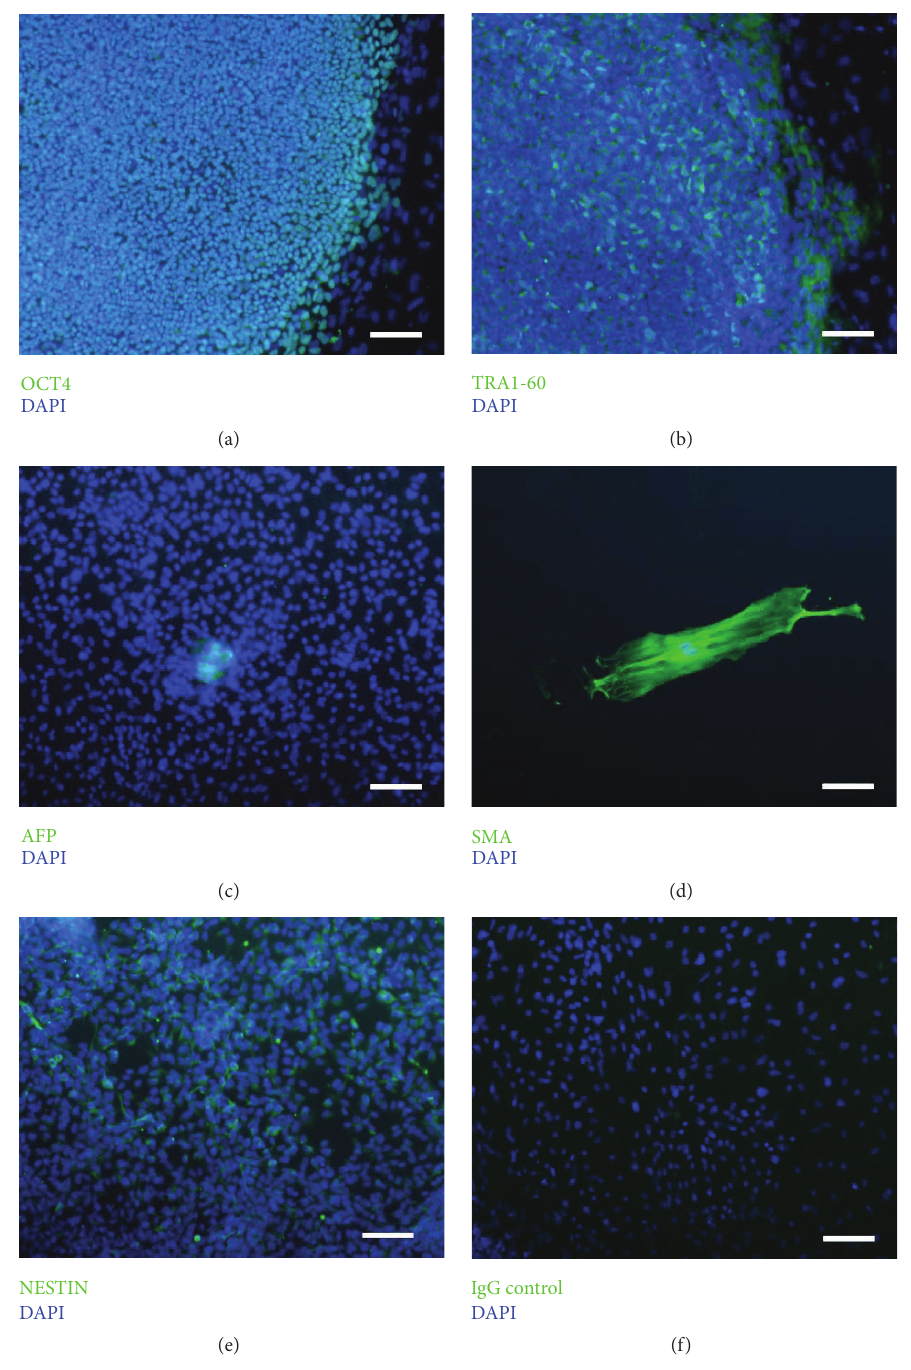
Figure 1: Characterisation of human iPSC line CERA007c6. Representative images showing expression of pluripotency markers (a) OCT4 and (b) TRA1-60 in the undifferentiated cells. CERA007c6 can be differentiated into all three lineages: (c) endoderm (alpha-fetoprotein, AFP), (d) mesoderm (smooth muscle actin, SMA), and ectoderm (Nestin). (f) An IgG negative control. Scale bar = 100 𝜇 m.